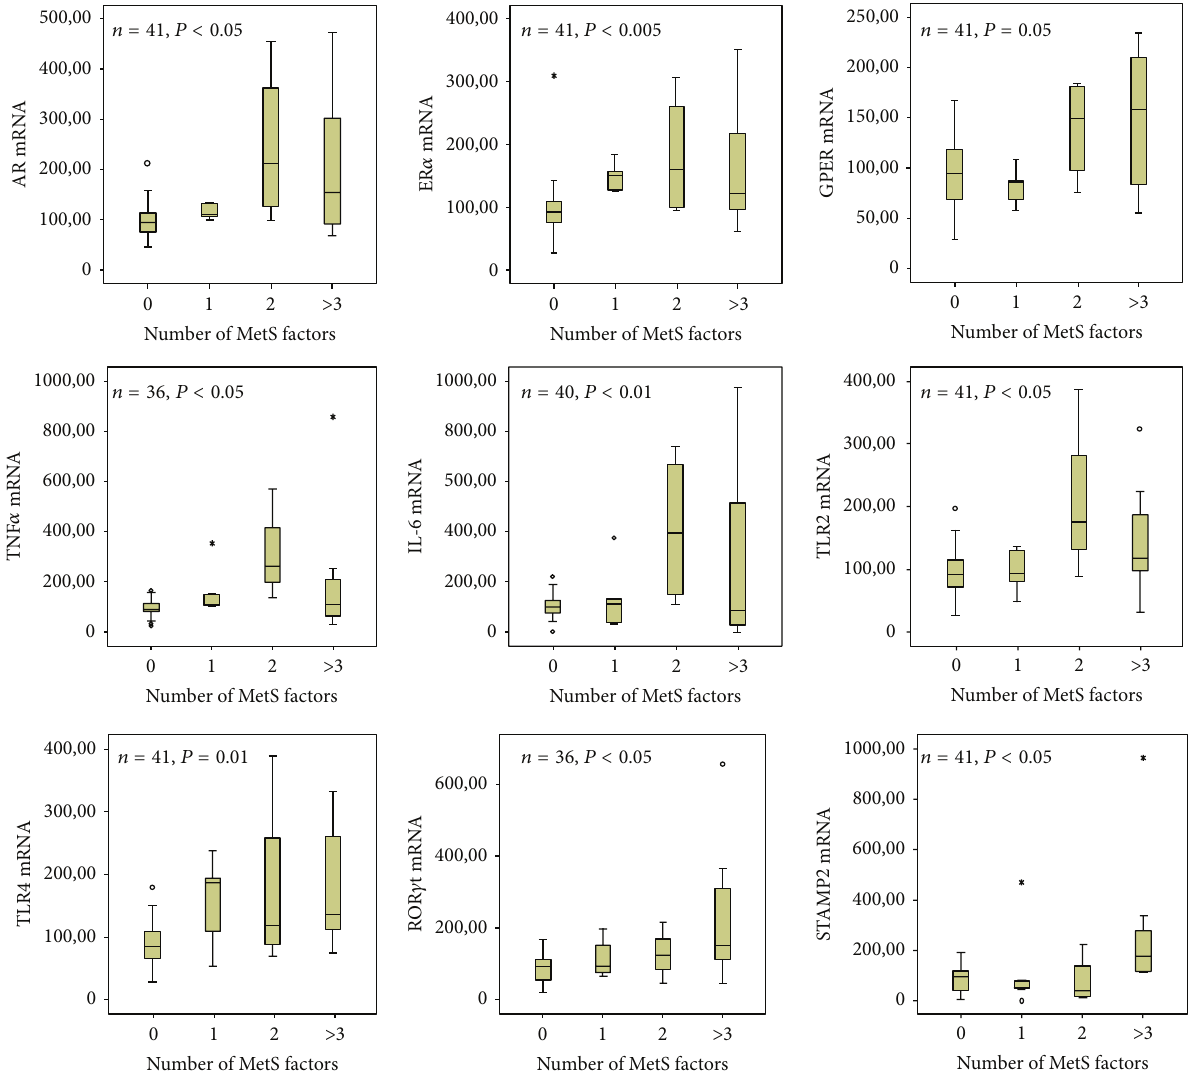
Figure 2: Gene expression of sex steroid receptors (upper panel) and inflammatory markers (middle and lower panels) in prostate of rabbits fed a regular diet (RD) or a high fat diet (HFD), according to metabolic syndrome (MetS severity). MetS severity was categorized as previously described [138], according to the number of factors present (abscissa). Ordinate axis indicates level of mRNA expression in arbitrary unit, as derived from quantitative RT-PCR analysis of the indicated prostate samples. Level of significance was derived from Kruskall-Wallis analysis of the